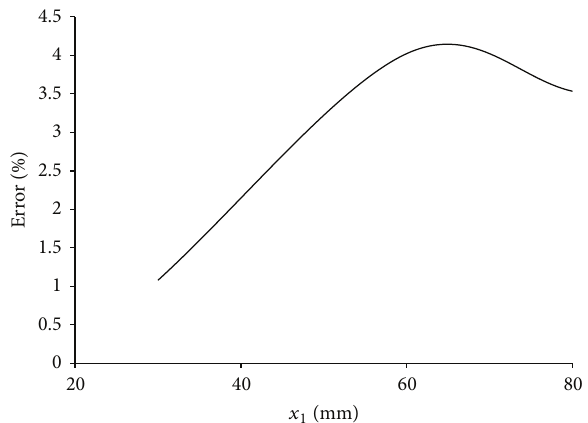
Figure 8: Error between experimental and FEM results for 𝜔 = 1000 rpm (DT = 20 s).